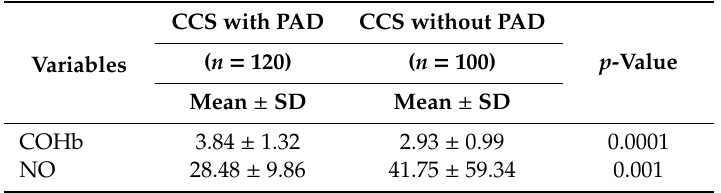
Table 2. Carboxyhemoglobin and Nitric oxide levels of the study